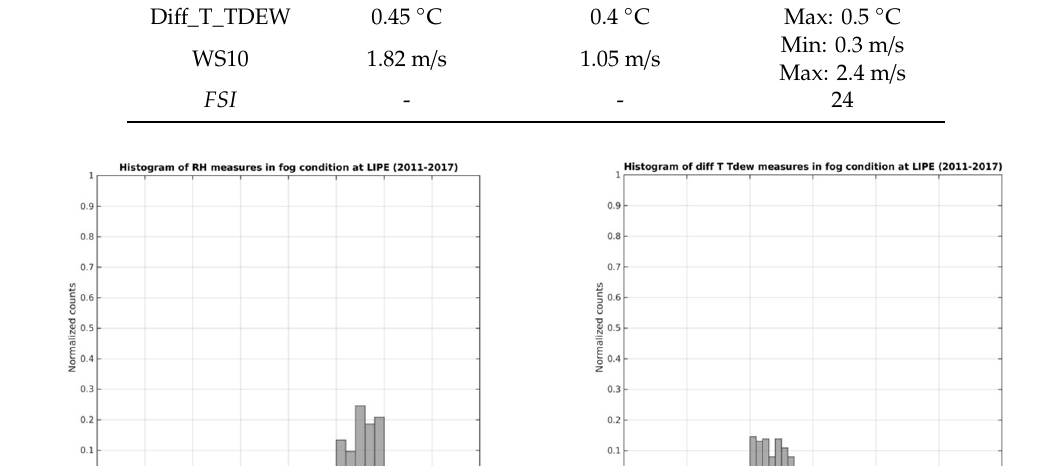
index for Bologna.